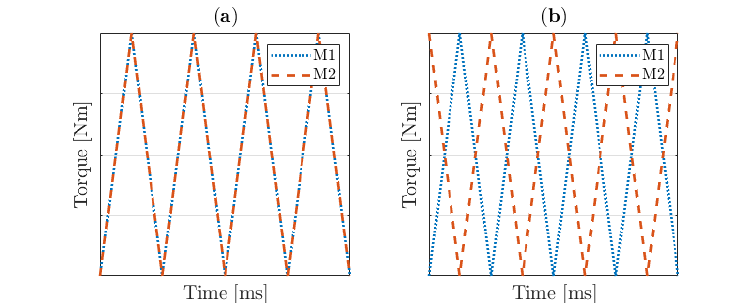
Figure 8. Theoretical electromagnetic motor torque ripple in modular scenario: ( a ) with synchronized control; ( b ) with interleaving control.